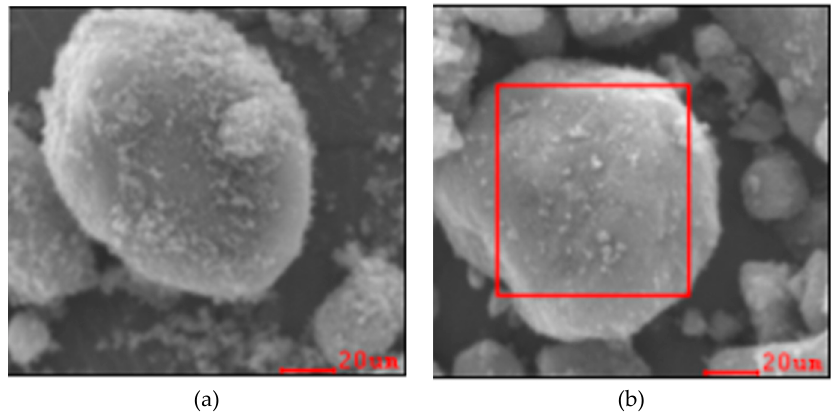
Figure 3. The microstructures of ( a ) CB and ( b ) HCB.